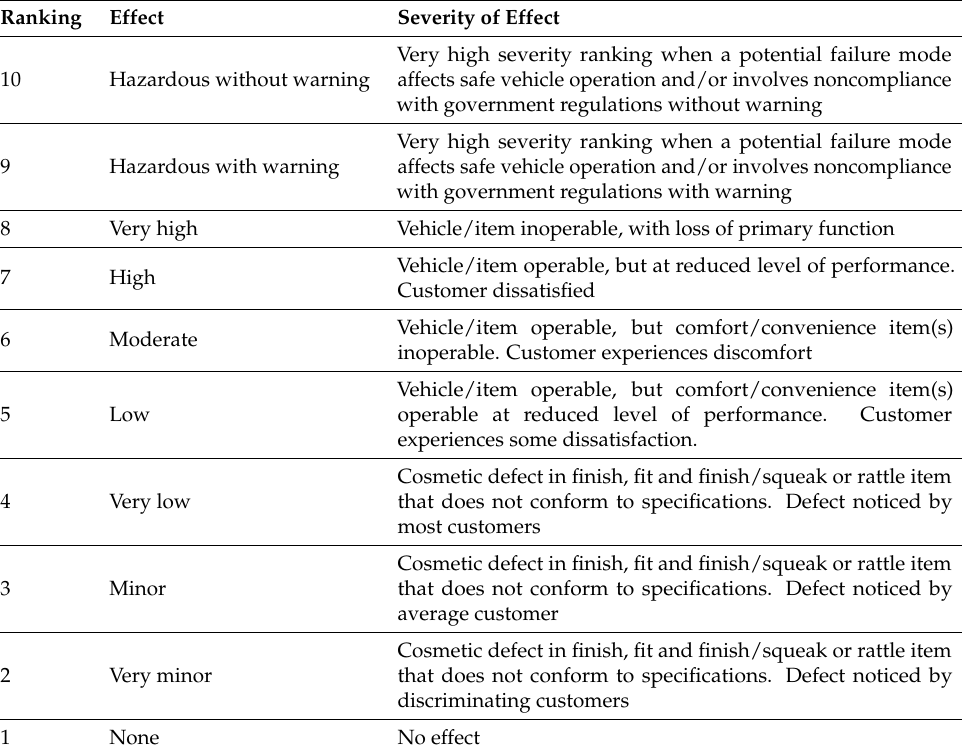
Table 2. Assessment rankings for severity in FMEA [38,39].